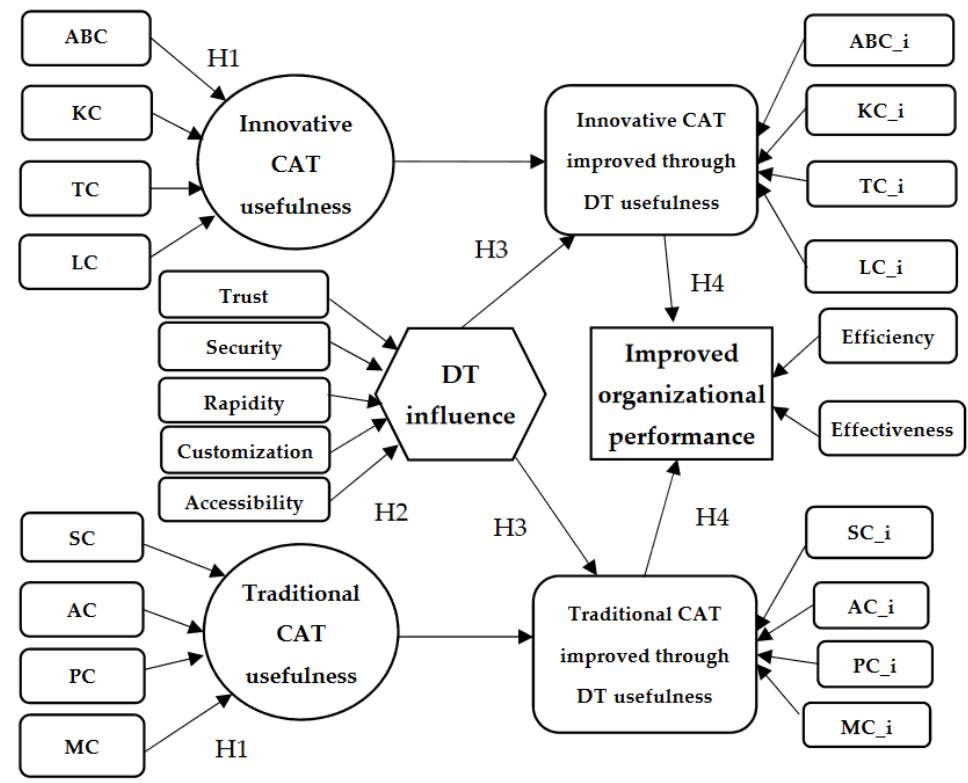
Figure 1. Theoretical model. Source: own construction.